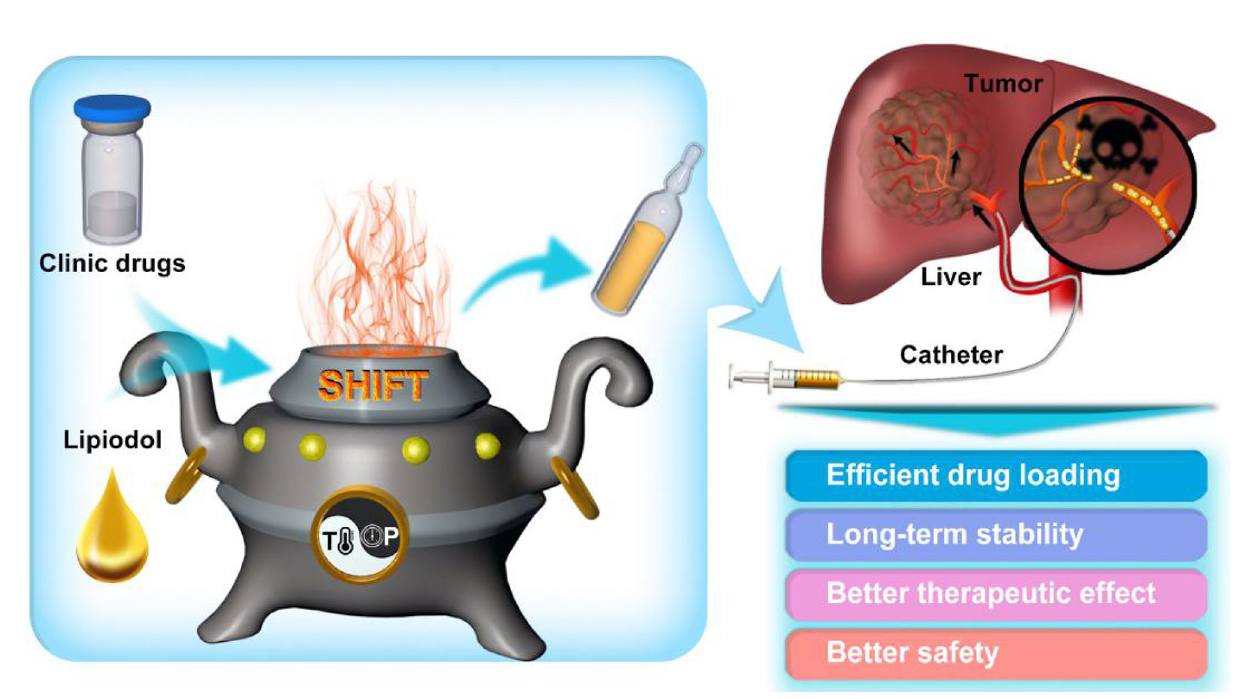
FIGURE 2 | Schematic illustration of super-stable homogeneous lipiodol formulation technology (SHIFT) as a revolutionary strategy for transhepatic arterial chemotherapy and embolization (TACE). The clinic drugs and lipiodol are introduced to develop formulations with SHIFT at a controlled temperature and pressure overcoming current challenges in the hepatocellular carcinoma (HCC) treatment with TACE. (Reprinted with permission from Liu et al. (56). Copyright Elsevier